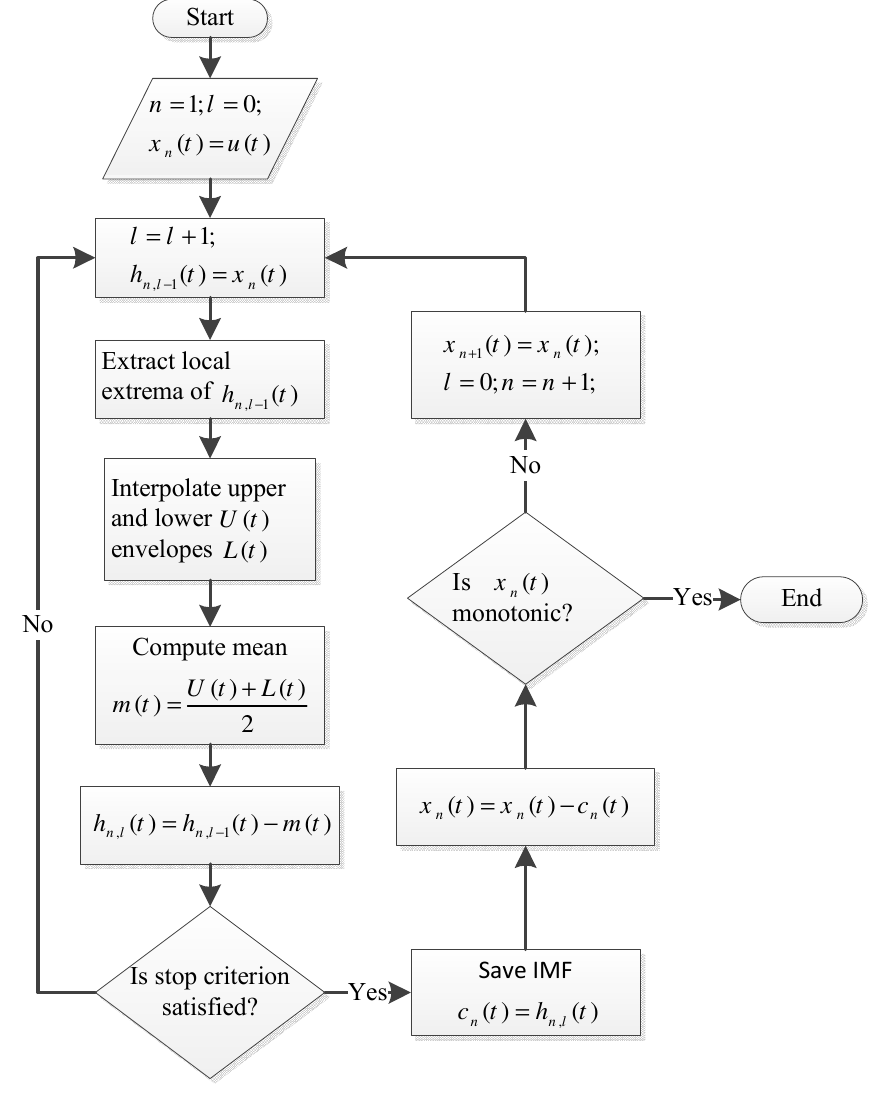
Figure 6. Implementation of the empirical mode decomposition